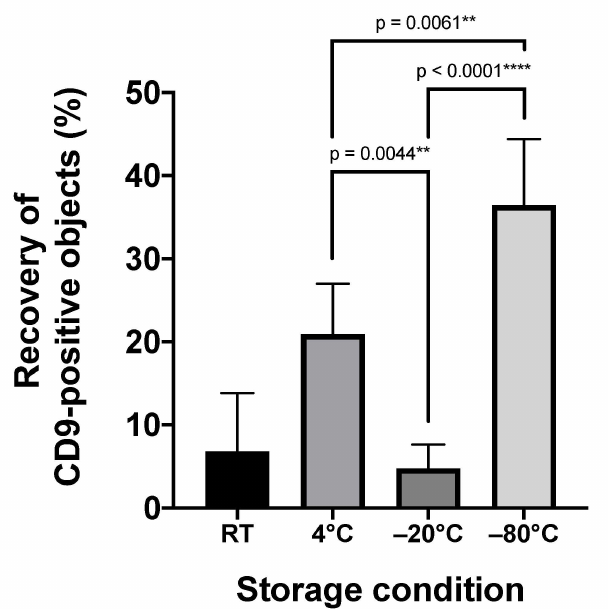
Figure 2. Recovery rates of CD9 + uEVs in void urine samples depend on the storage temperature. Freshly prepared, cell-free void urine samples (n = 5) were analyzed by IFCM immediately after antibody staining with anti-CD9 antibodies (no storage) or after storage for 1 month either at room temperature, ((RT) 20 ◦ C), 4 ◦ C, − 20 ◦ C, or − 80 ◦ C. The recovery of CD9 + objects in stored samples was calculated as the ratio of CD9 + objects before and after storage. ** p ≤ 0.01, **** p ≤